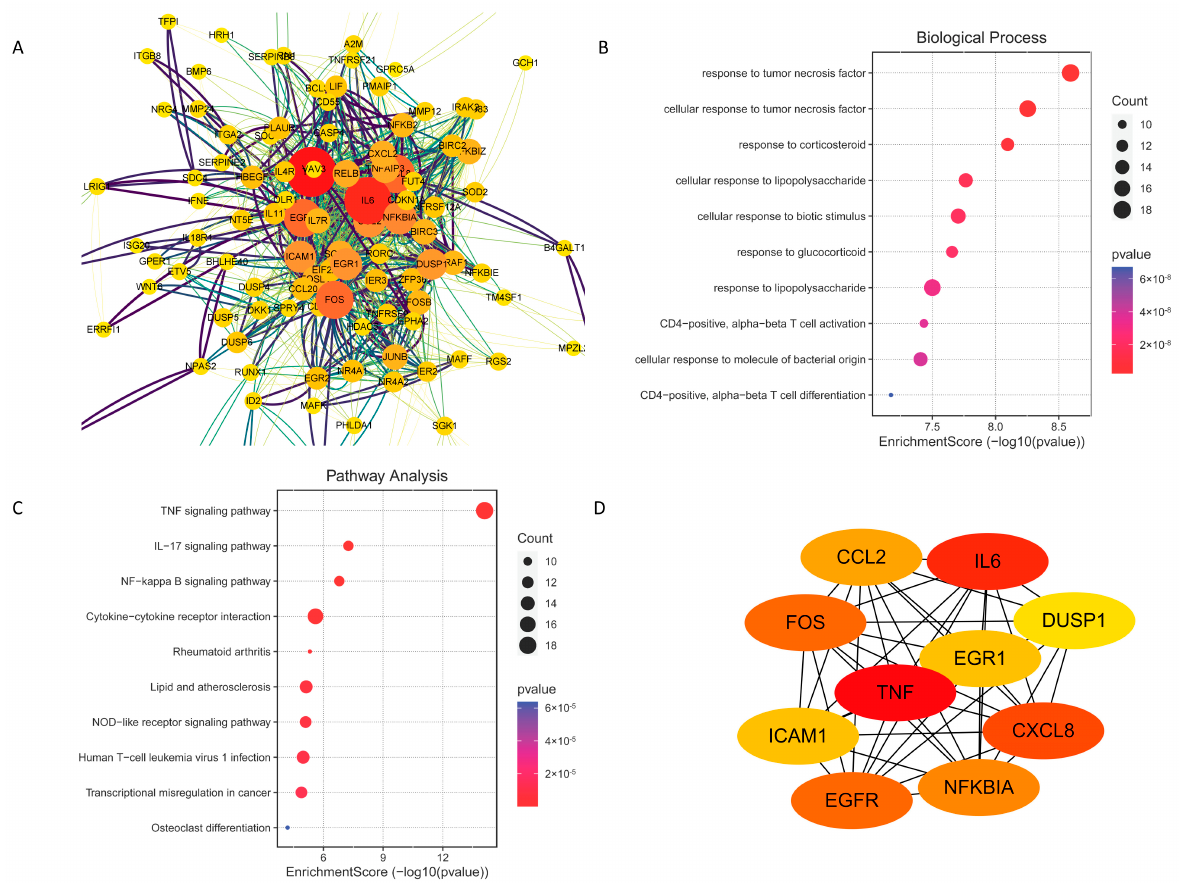
Figure 5. PPI network analysis and identification of Hub Genes. ( A ) PPI network of 194 DEGs. The larger size and darker color represent more interactions of nodes. ( B ) Top 10 significantly enriched GO terms in biological processes (BPs). ( C ) The 20 pathways with the lowest adjusted p values. ( D ) PPI network of the hub genes.